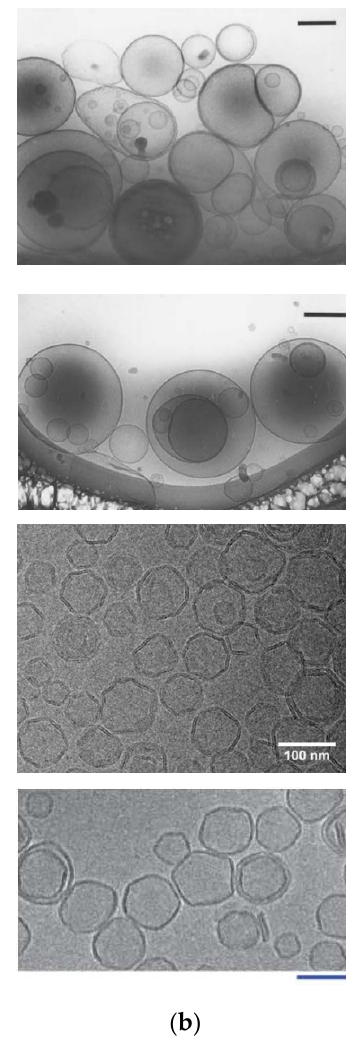
Figure 12. Aqueous dispersions of DPPC. ( a ) Top : Binary DPPC/water phase diagram, as published by Koynova and Caffrey (1998) [101]. Bottom : Schematic drawings of the fluid, liquid-disordered lamellar phase (L α ) [84], and a snapshot from a molecular dynamics simulation of a DPPC bilayer in the L α state [106], of the the solid-ordered ripple phase (P β′ ) [107,108], and of the solid-ordered lamellar phase (L β′ ) [84]. ( b ) Cryo-TEM images of aqueous DPPC vesicle dispersions. From top to bottom : First and second : dispersion of DPPC in 50 mM Mes buffer ( pH = 6.0, 150 mM NaCl, 5 mM EDTA), as obtained by repeated freezing in liquid nitrogen and thawing at T > T m ~ 41 °C (bar: 200 nm), either quenched from T = 50 °C ( first ) or T = 25 °C ( second ); see El Jastimi et al. (1999) [109]. Third: dispersion of DPPC in 10 mM Tris-HCl buffer ( pH = 7.4), as obtained by repeated extrusion through 100 nm polycarbonate membranes at T = 60 °C (bar: 100 nm), and quenched from T = 25 °C; see Farkuh et al. (2019) [110]. Fourth: dispersion of DPPC in D 2 O, as obtained by repeated extrusion through 100 nm polycarbonate membranes (bar: 100 nm), and quenched from T = 25 °C, see Matviykiv et al. (2019) [111]. Reproduced from [84], copyright © Taylor and Francis, 2013; and with permission from [101], Elsevier, 1998; from [106], AIP Publishing, 1996; from [107], Springer Nature, 2000; from [109], Elsevier, 1999; from [110], Elsevier, 2019; and from [111], American Chemical Society, 2019.